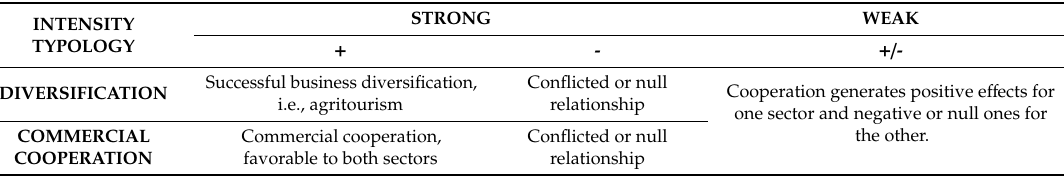
Table 1. Categories of intersectoral relationships between agriculture and